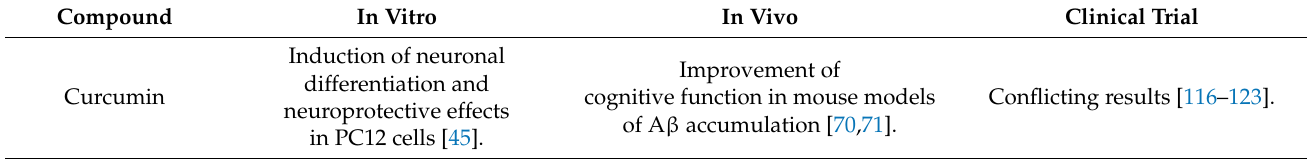
Table 1. Evidence from substances treatment supporting a role for NRF2 in maintaining and improv- ing cognitive function. In this table are reported a summary of results from substance tested in vitro and/or in vivo and in clinical